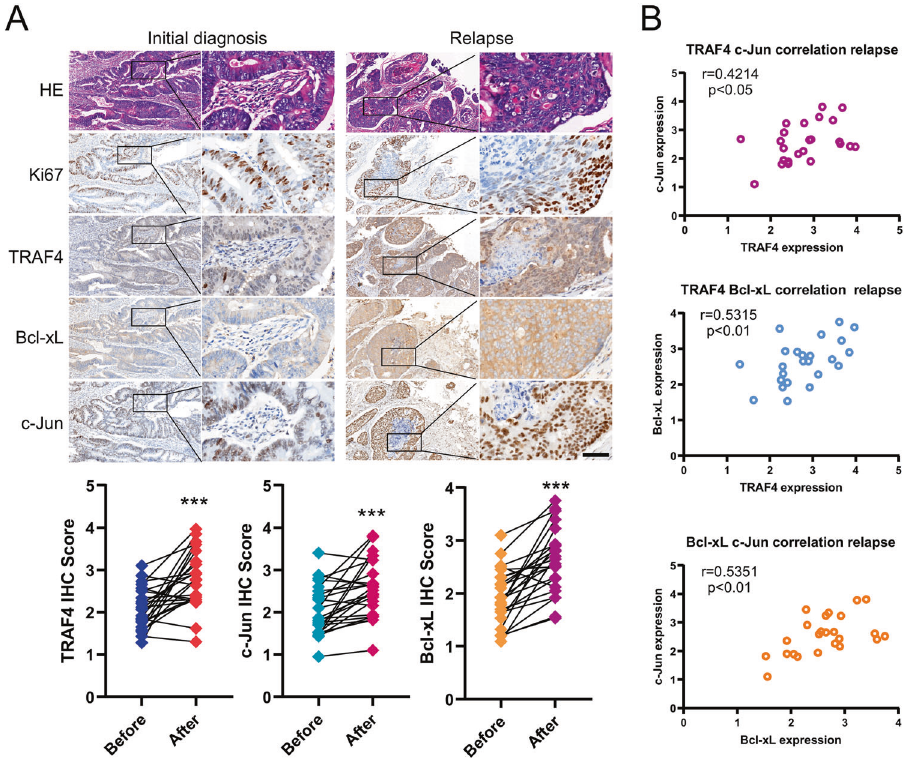
Fig. 7 TRAF4 is upregulated and positively correlates with Bcl-xL in samples of patients with colorectal cancer. A Top, IHC staining was performed to determine Ki67, TRAF4, Bcl-xL and c-Jun in 24 cases paired primary and relapsed tumor tissues. Bottom, Image-Pro-PLUS (v.6) and Image J (NIH) computer software were used to quantify staining intensity. *** p < 0.001. Scale bar, 50 μ m. B Scatterplot shows the positive correlation between c-Jun and TRAF4 (top), Bcl-xL and TRAF4 (middle), c-Jun and Bcl-xL (bottom) expression in the relapsed